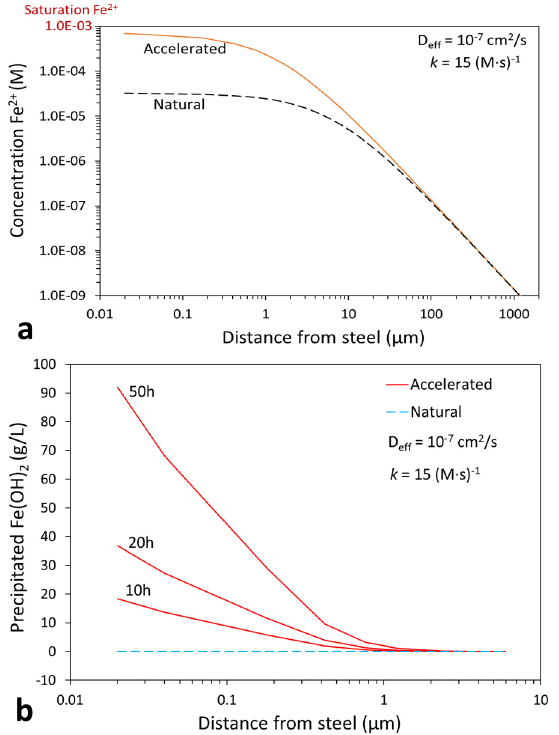
Figure 7. (a) Fe 2+ concentration at the steady state, in case of accelerated corrosion testing in comparison with natural corrosion conditions. The accelerated process causes more than one order